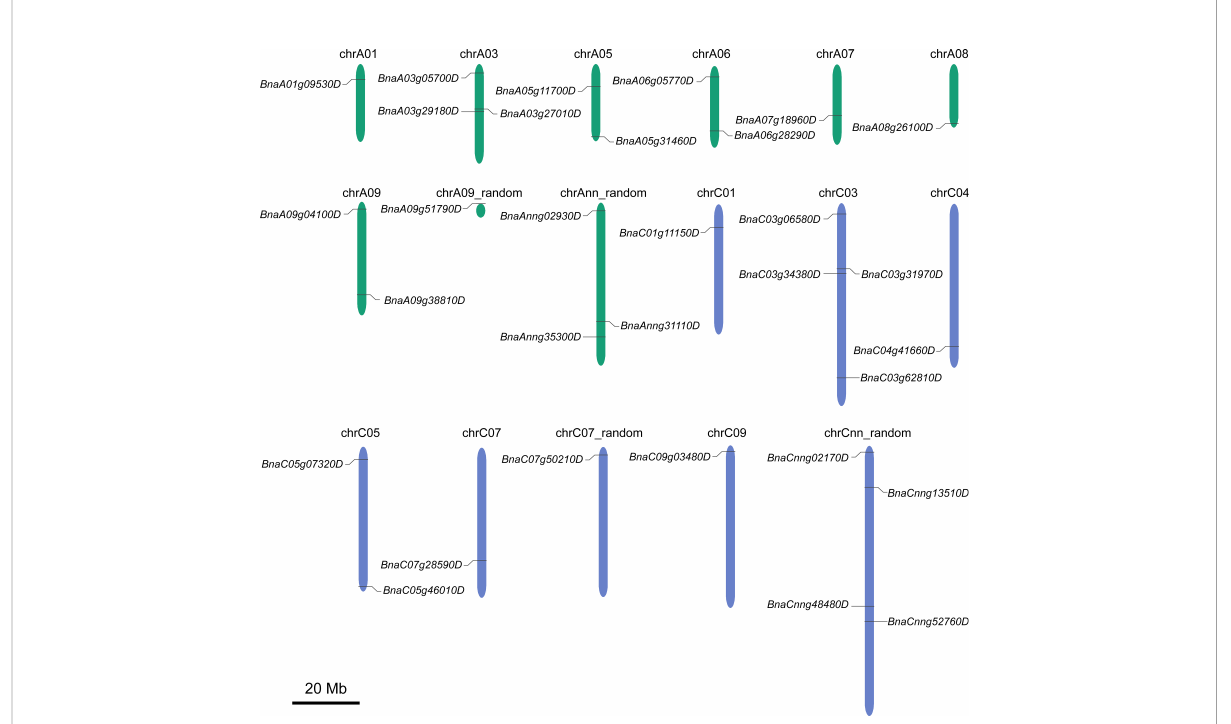
FIGURE 3 Chromosomal distribution of BnGSK3s in the genome of Brassica Napus . Green and blue chromosomes represent A and C sub-genome of B . napus ,